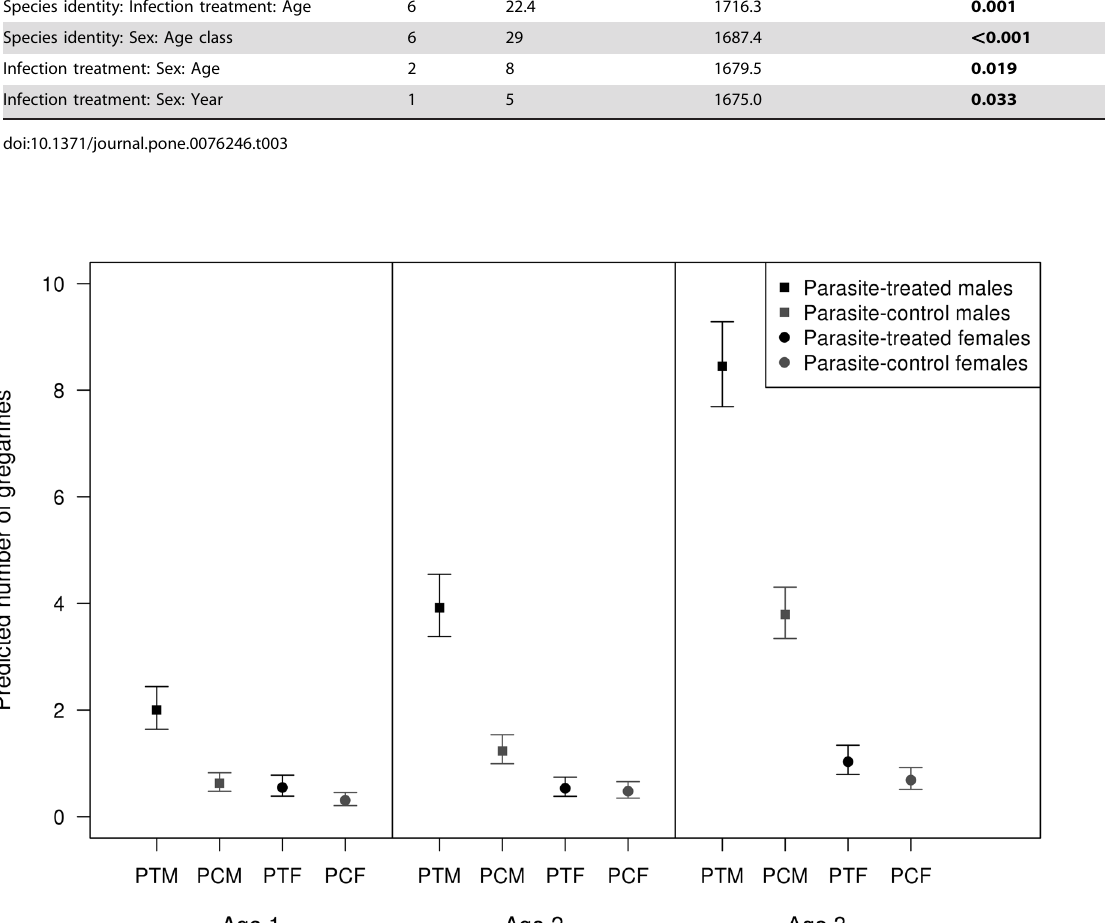
Df Deviance Residual deviance Probability ( x 2